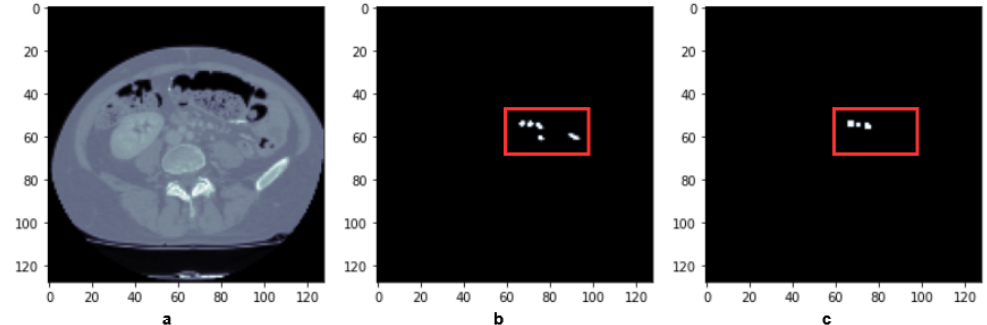
Figure 8. Portal vein sample 1: ( a ) image, ( b ) original mask, and ( c ) predicted mask without zooming in the pre-processing.